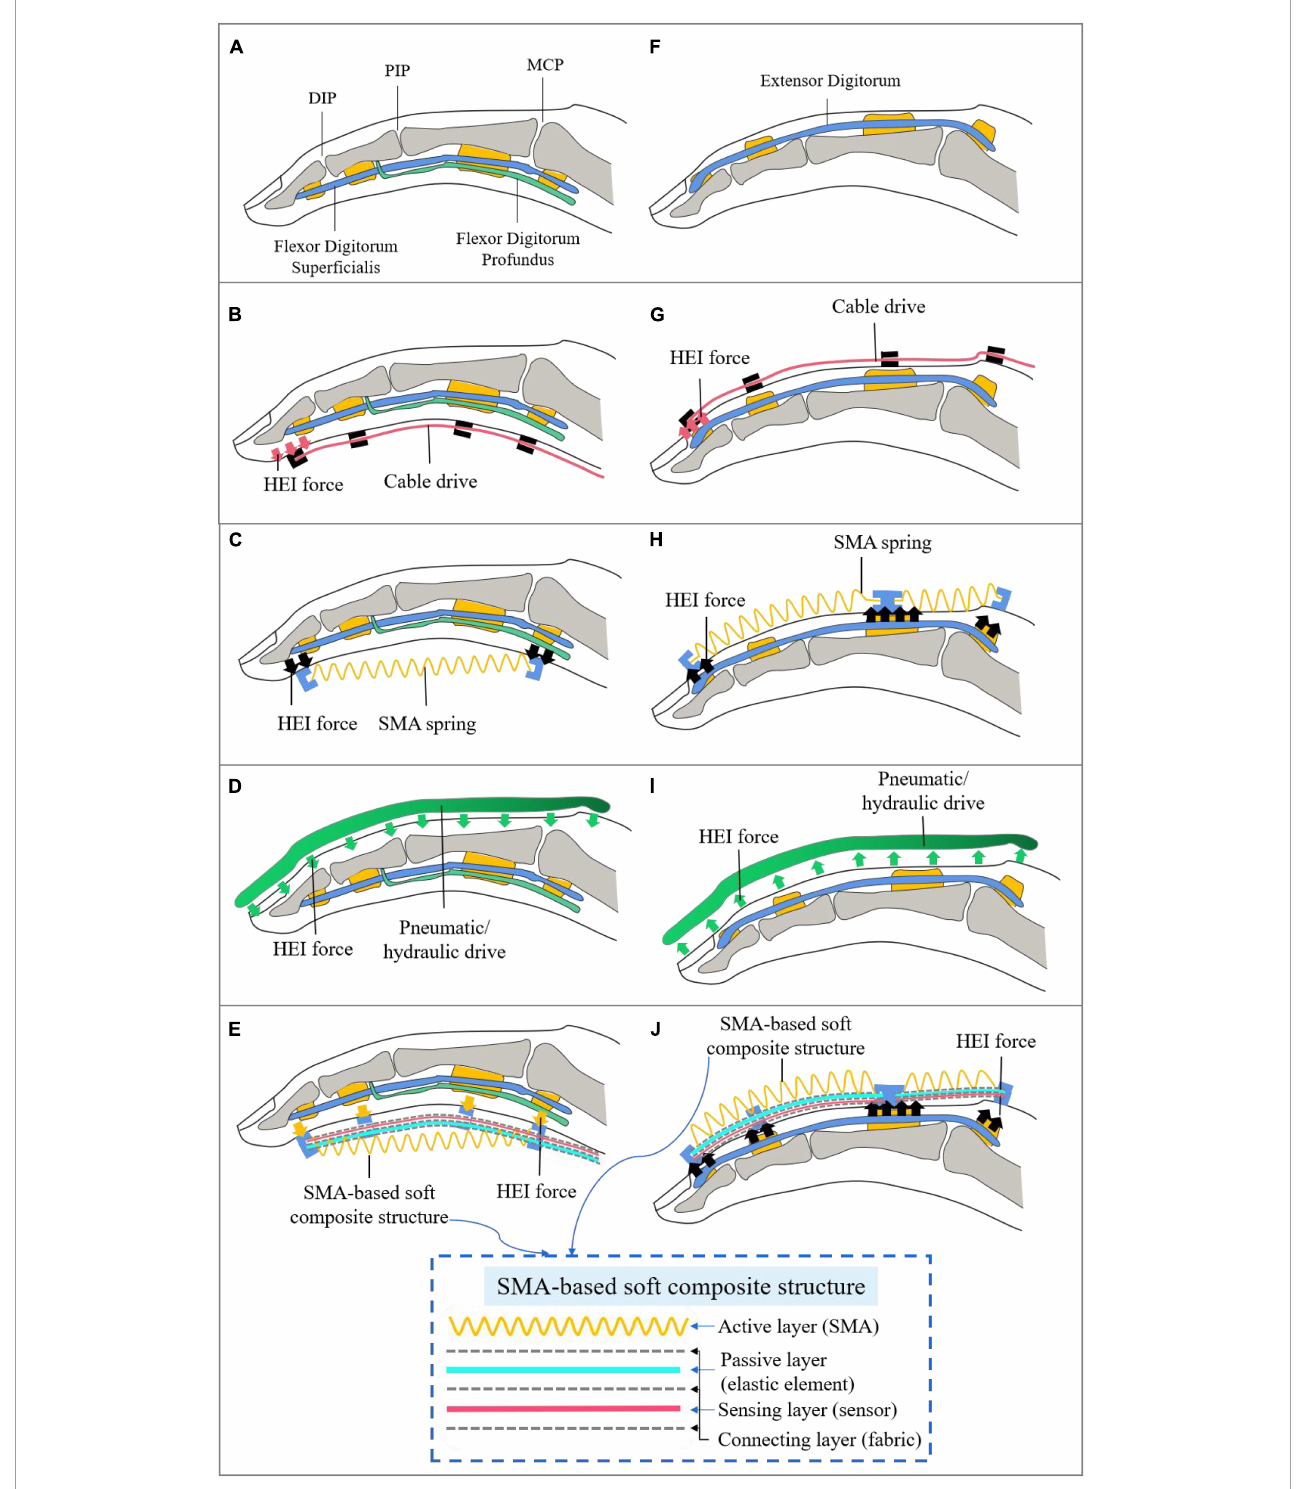
FIGURE2 Finger force models in different drive modes. HEI, human-exoskeleton interaction. (A,F) The model of the bones and muscles of finger flexion and extension; (B,G) the cable-actuated force model of finger flexion and extension; (C,H) the force model of the SMA spring contraction directly actuating the finger movement; (D,I) the force model driven by pneumatic actuators of finger flexion and extension; (E,J) the force model of the driving finger driven by SMA-based soft composite structure.